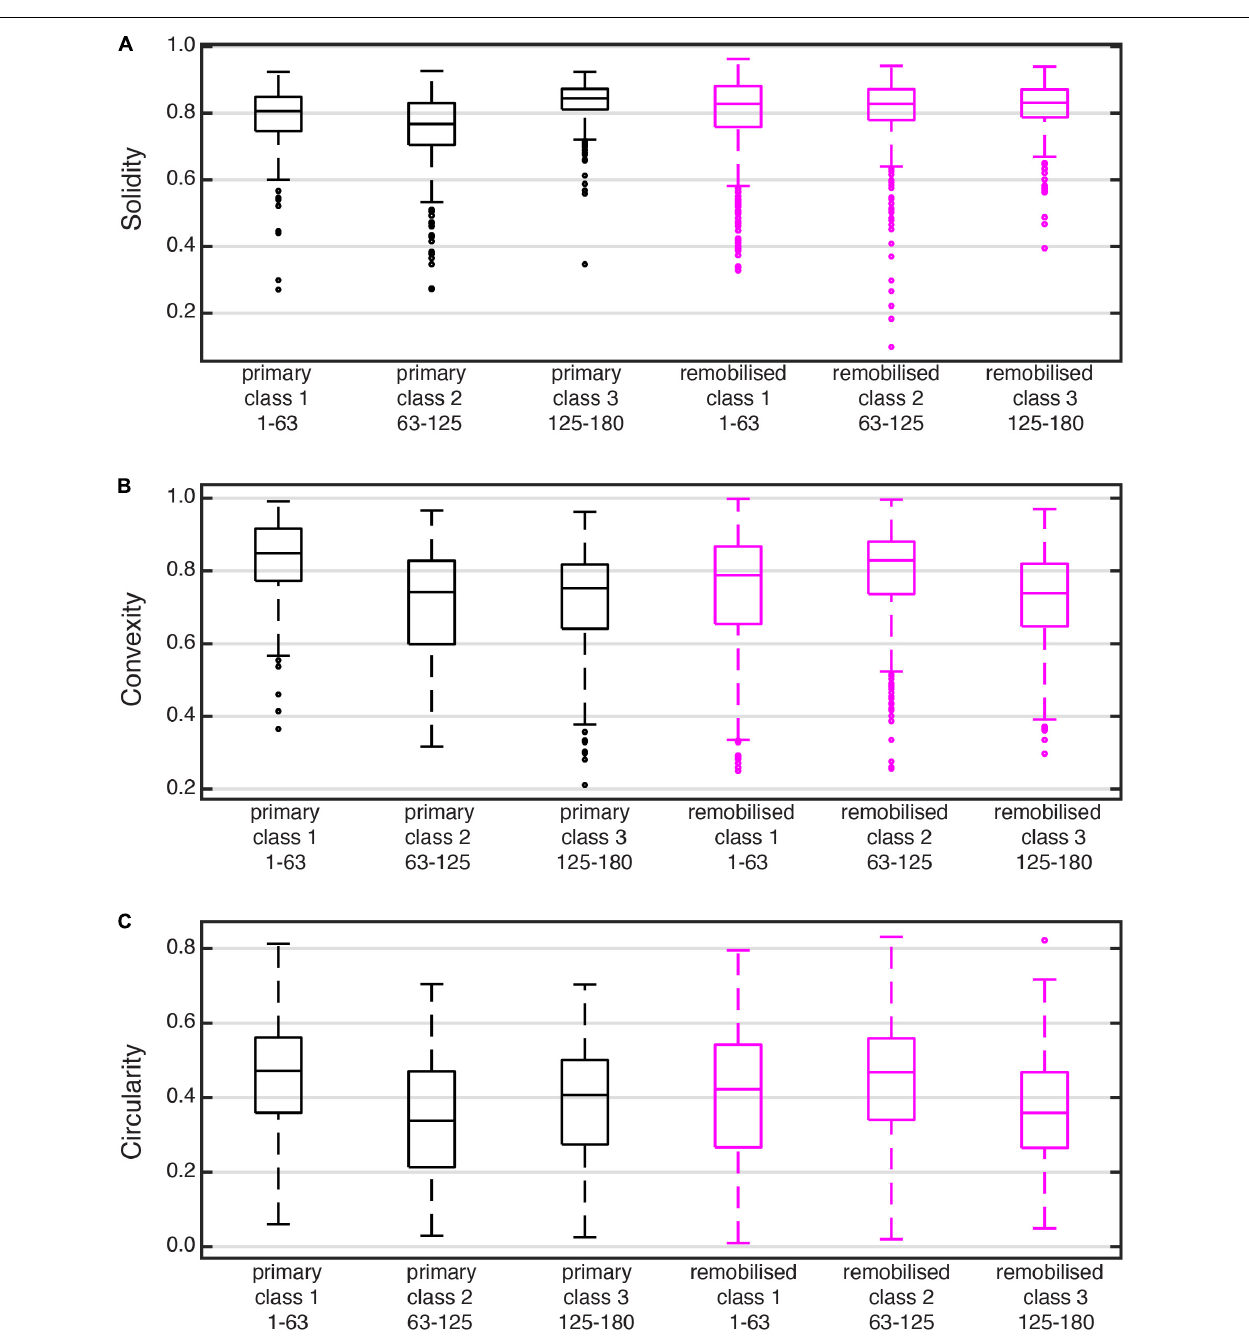
FIGURE 9 | Box and whisker plots showing comparison of (A) solidity, (B) convexity, and (C) circularity for primary and remobilised ash. The three parameters are dimensionless and scaled from 0 to 1, being 1 the perfect circle. Lower and upper edges of each box indicate the 25 and 75% percentiles, respectively, with the middle line corresponding to the median. Box width represents the variability of values within the same sample. The whiskers extend to the most extreme values and the points correspond to outliers.